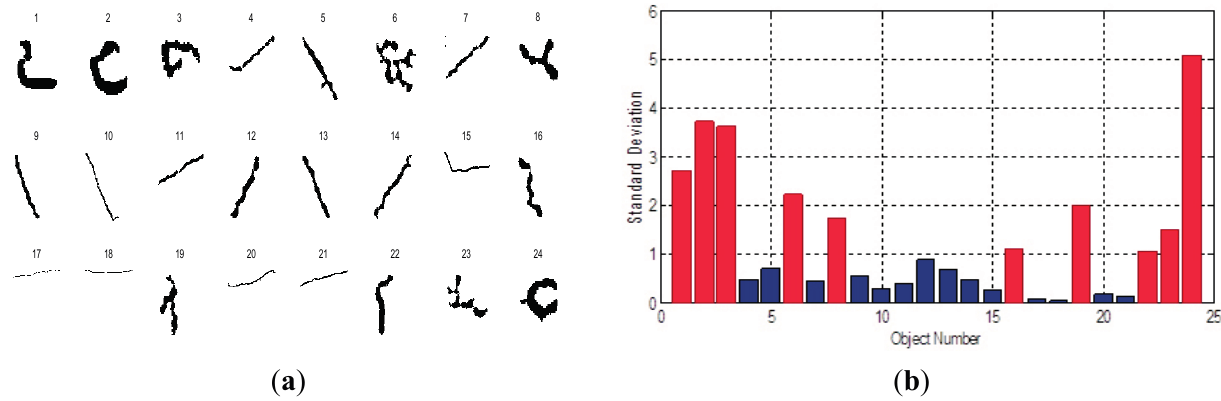
Figure 7. Comparison of the shape distance histogram standard deviation: ( a ) the candidate objects; ( b ) the corresponding standard deviations of distance